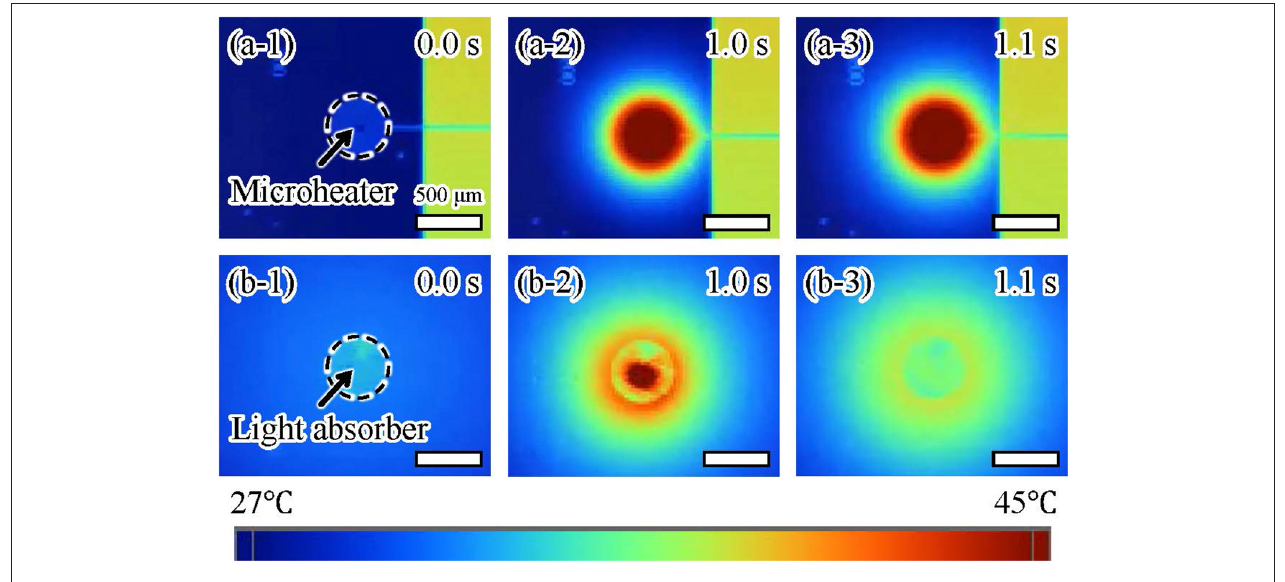
FIGURE 9 | Thermographic images of actuators driven by (a) a microheater and (b) light irradiation.